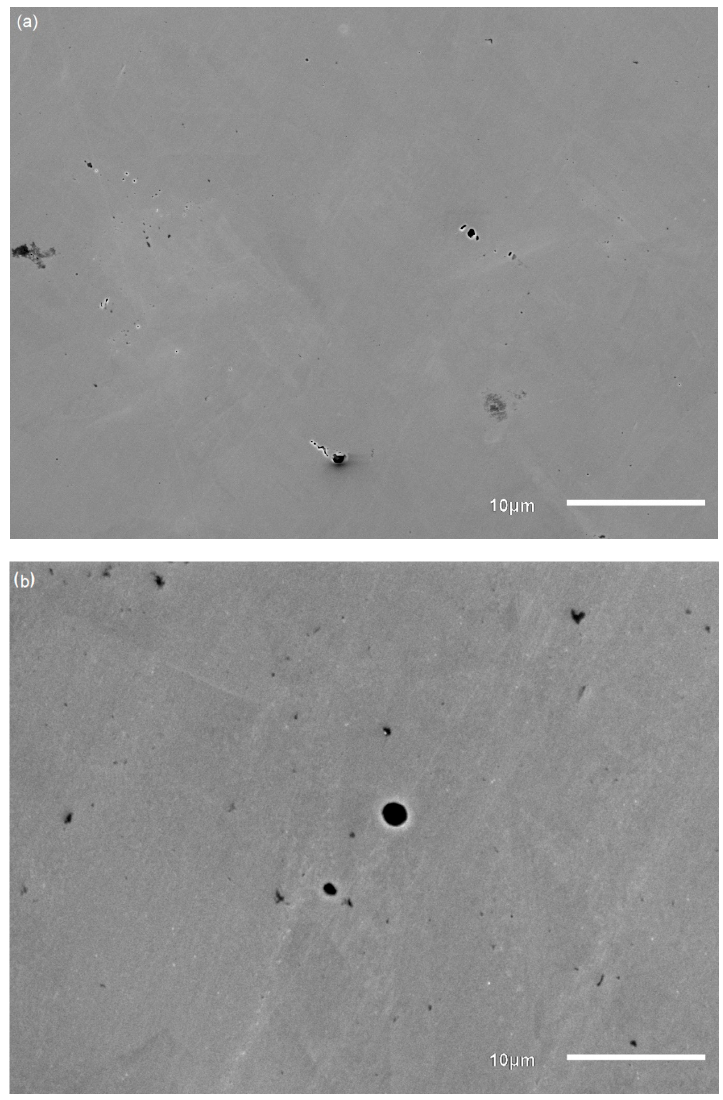
Figure 10. Concentrations of chromium, manganese, iron, nickel and molybdenum in the medium following immersion of coupons for 28 days in different pH environments. Appl. Sci. 2020 , 10 , x FOR PEER